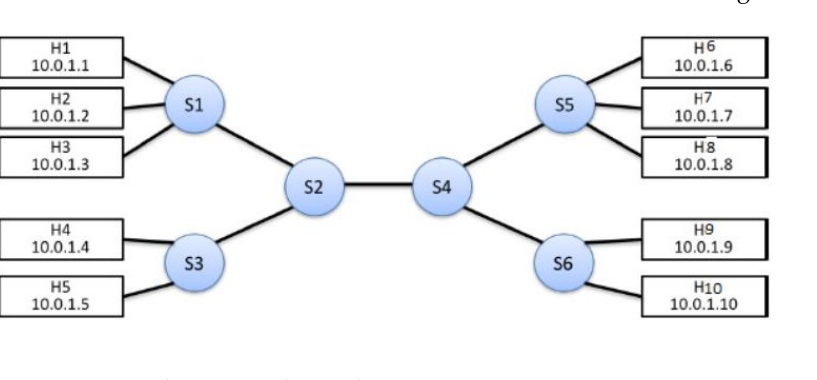
Figure 6. Network setup used in